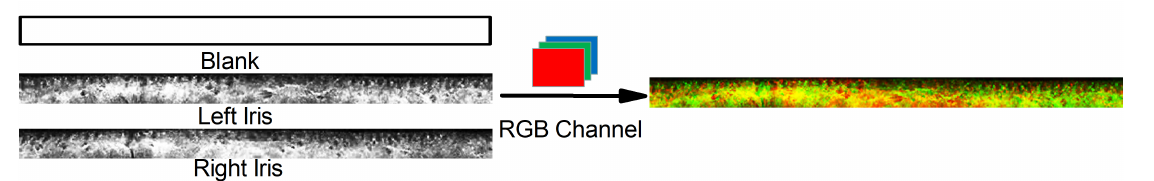
Figure 5. Illustration for the generation of a CNN (convolutional neural network) input image from two iris images ( left and right ).